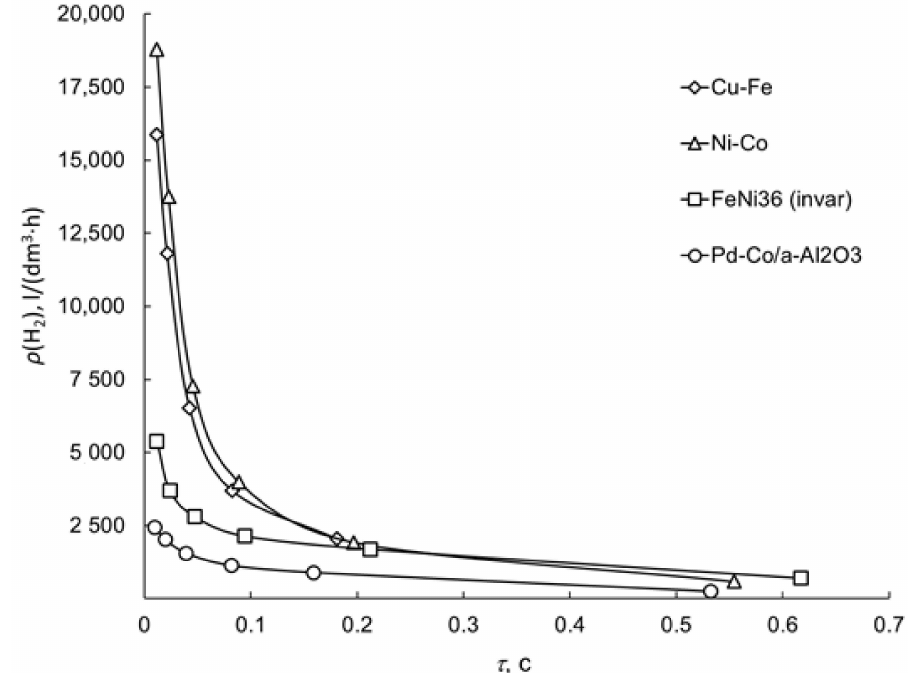
Figure 5. Dependence of the specific productivity to hydrogen on the conditional contact time for water–gas shift reaction in porous catalytic converters of variable